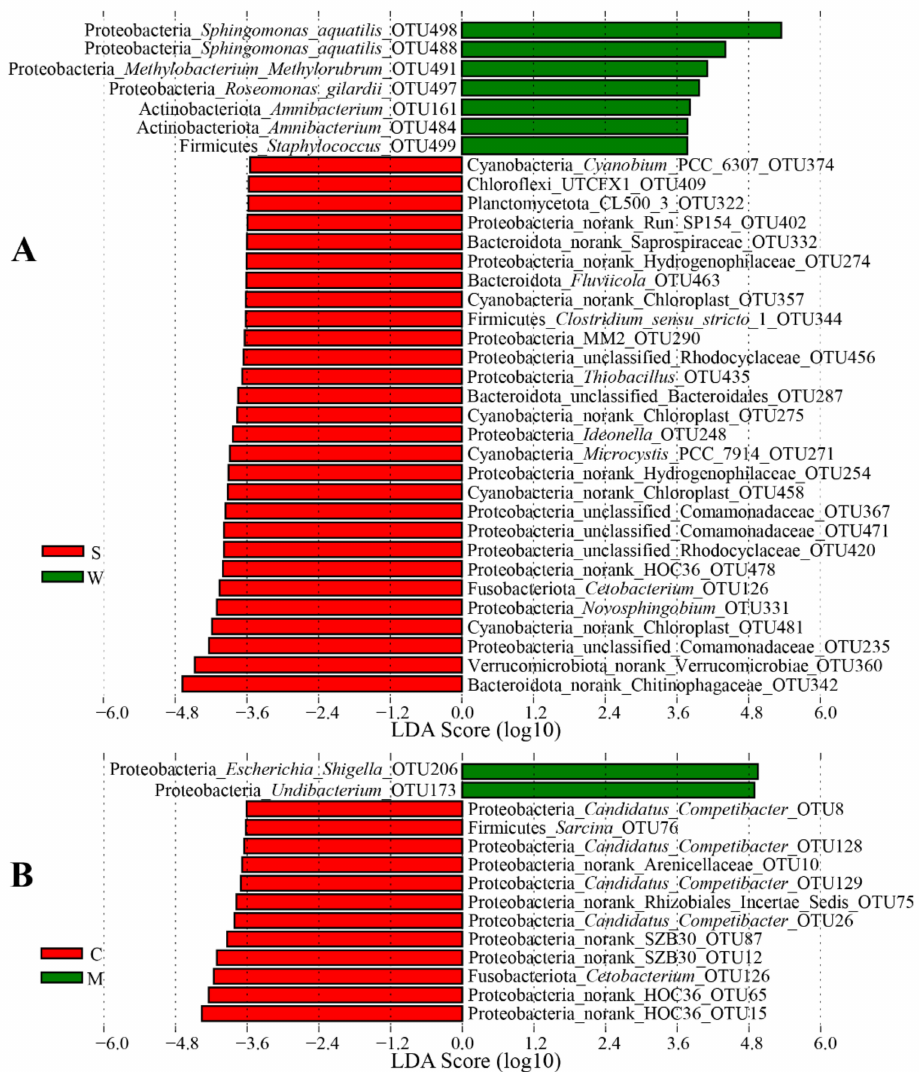
Figure 4. ( A ) Linear discriminant analysis (LDA) effect size (LEfSe) showing differences in the bacterial communities at the operational taxonomic unit (out) level between the stomach contents and stomach mucosae. ( B ) LEfSe showing differ- ences in the bacterial communities at the OTU level between the intestinal contents and intestinal mucosae. The highlighted taxa are enriched in the group that corresponds to each color. LDA scores can be interpreted as the degree of difference in the relative abundance of OTUs. S: stomach contents (S1–S4); W: stomach mucosae (W1–W4); C: intestinal contents (C1–C4); M: intestinal mucosae